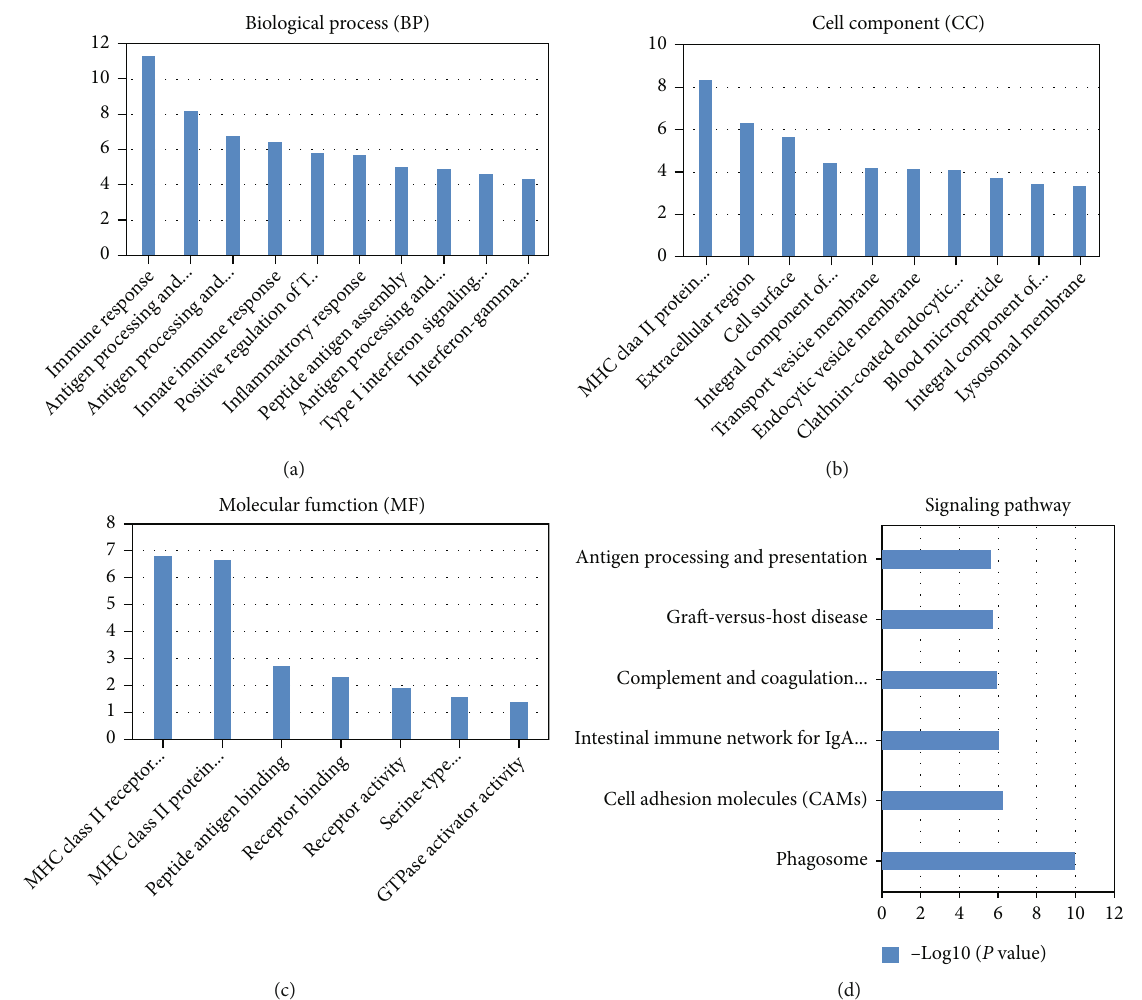
Figure 2: Functional assessment for common upregulated DEGs of three datasets by DAVID: (a) top 10 BP results; (b) top 10 CC results; (c) signi fi cant MF results ( P < 0 : 05 ); (d) signi fi cant enriched KEGG signaling pathways ( P < 0 : 05 ).